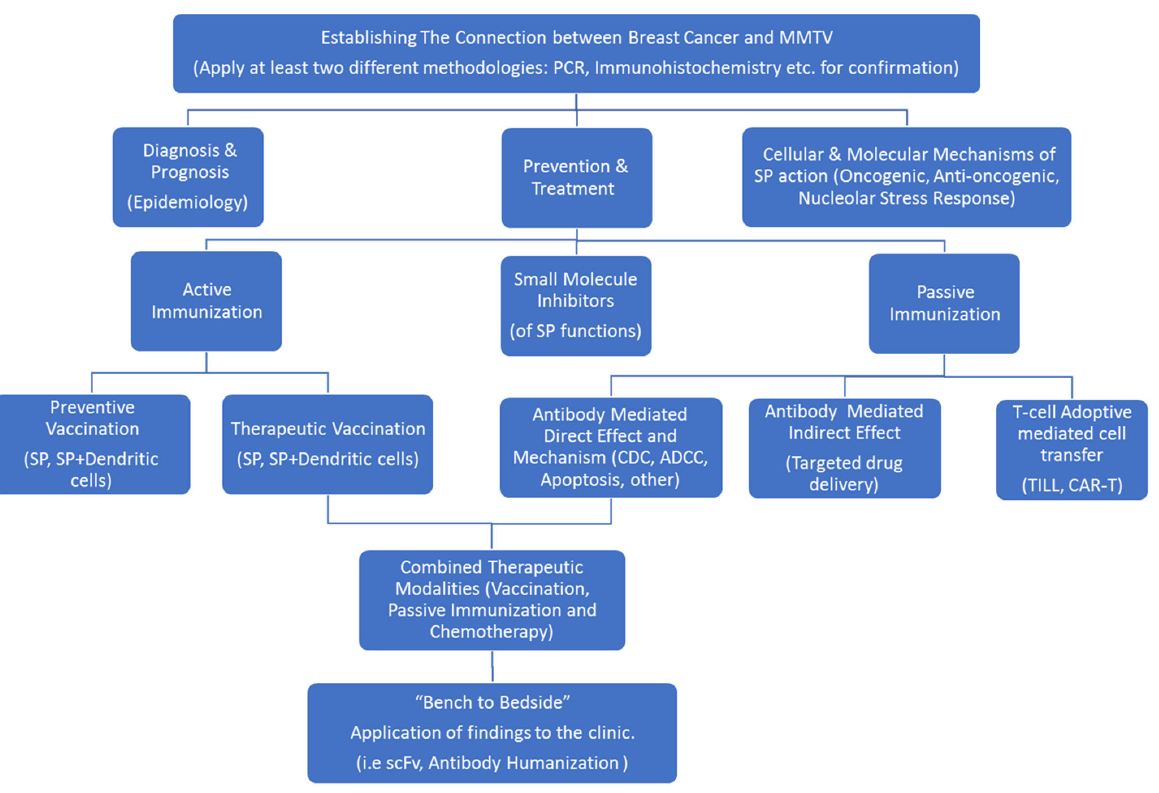
Figure 8. Signal-peptide-based road map for the diagnosis, prevention and treatment of MMTV (HMTV, HBRV)-associated breast cancer and other maladies (i.e., primary biliary cholangitis) associated with the virus in the clinical setting.